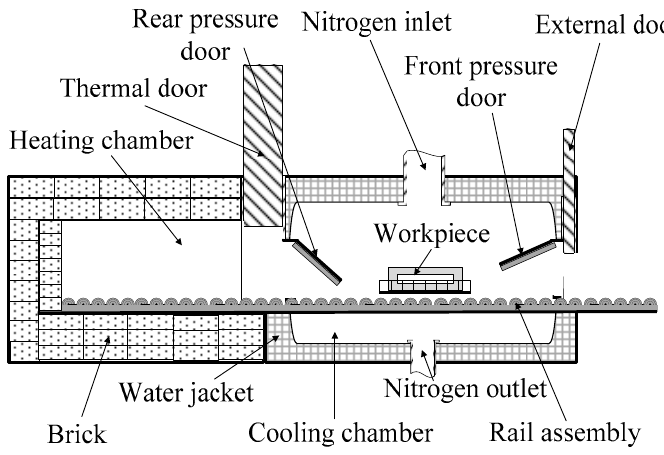
Figure 5. Schematic drawing of the door system designed for the cooling process.